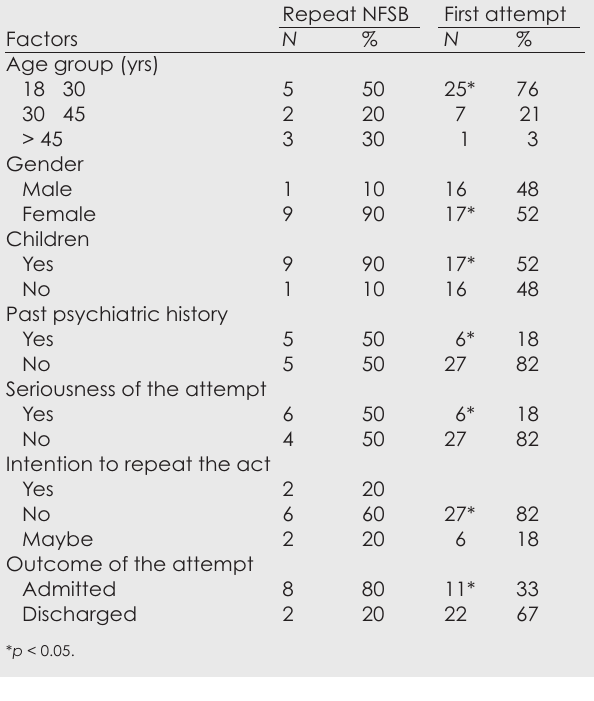
Table II. Factors associated with non-fatal repetition Table I. Characteristics of non-fatal suicide behaviour in 43